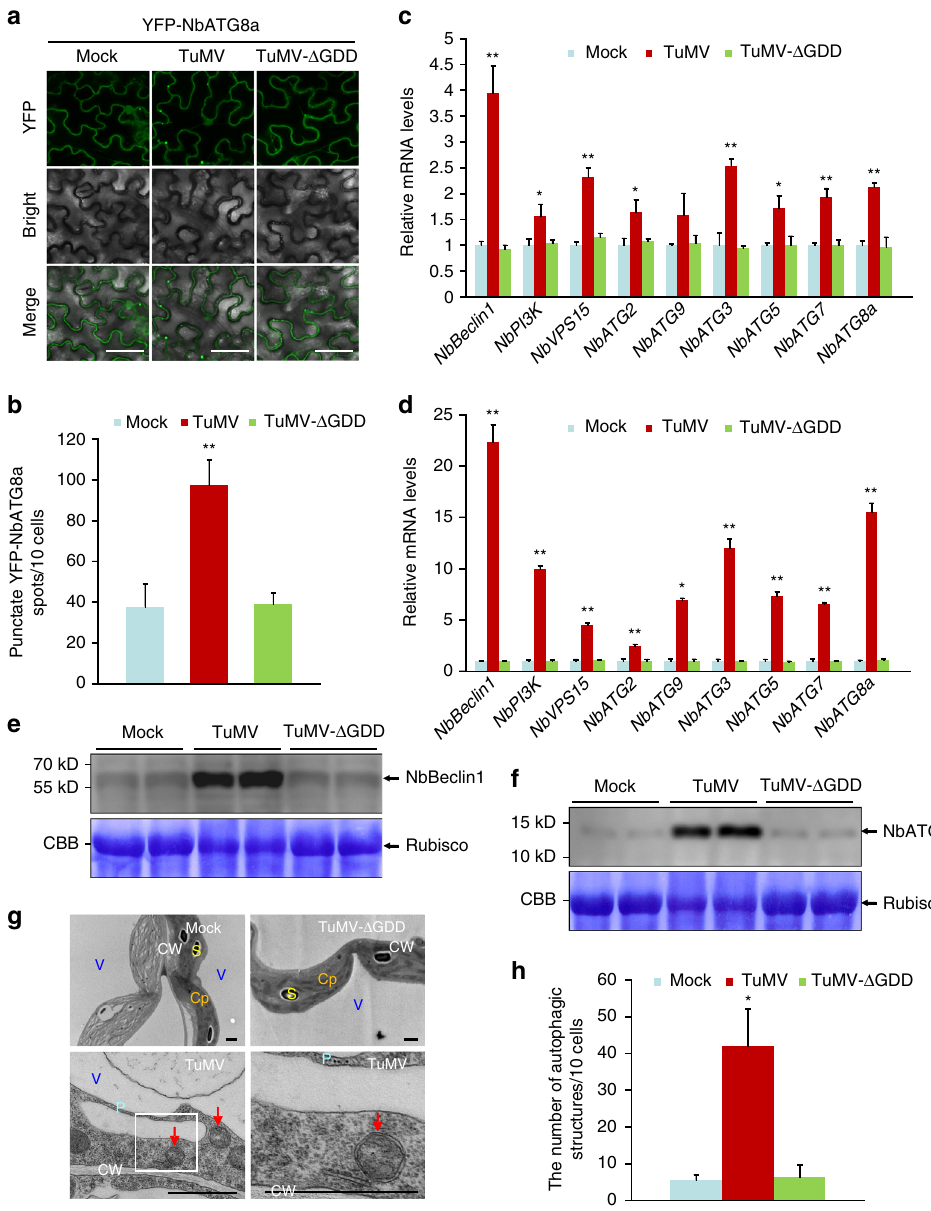
Fig. 1 TuMV infection activates autophagy. a Confocal micrographs showing N . benthamiana leaf cells co-in fi ltrated with Agrobacterium harboring a YFP-NbATG8a expression construct and Agrobacterium carrying an empty vector (mock) or a TuMV infectious clone (TuMV) or a TuMV replication- defective mutant (TuMV- Δ GDD) at 60 h post in fi ltration (hpi). Bars, 50 μ m. b The average number of YFP-NbATG8a spots per 10 cells. In fi ltration experiments were repeated three times and 60 cells in total were counted for the punctate spots. The average number was calculated using 10 cells as a unit. Values represent the mean spots ±standard deviation (SD) per 10 cells. c , d Effects of viral infection on the expression of autophagy components at 3 and 7 days post in fi ltration (dpi). N . benthamiana leaves were agroin fi ltrated with mock, TuMV, or TuMV- Δ GDD. Total RNAs were extracted from in fi ltrated zones at 3 dpi ( c ) or from newly emerged leaves at 7 dpi ( d ). Values represent the mean relative to the mock-treated plants ( n = 3 biological replicates) and were normalized with NbActin as an internal reference. e , f Immunoblotting analysis of total protein isolated from upper non-inoculated leaves of plants agroin fi ltrated with mock, TuMV, and TuMV- Δ GDD at 7 dpi with anti-Beclin1 ( e ) or anti-ATG8 ( f ) antibody. Coomassie Brilliant Blue R-250 (CBB)-stained Rubisco large subunit serves as a loading control. g Representative TEM images from upper non-inoculated leaves of N . benthamiana plants infected with mock, TuMV, and TuMV- Δ GDD at 7 dpi. Obvious autophagic structures (red arrows) were observed in TuMV-infected samples and the corresponding region in the white box in the left panel is magni fi ed in the right panel. Cp chloroplast, CW cell wall, P particle, S starch, V vacuole. Bars = 1 μ m. h The number of typical double-membrane autophagosomes in different samples in g . Experiments were repeated twice and typical autophagic structures were counted in 30 cells in each treatment. Values represent the mean number of autophagosomes ±SD per 10 cells. b , c , d , h Data were analyzed using Student ’ s t -test and asterisks denote signi fi cant differences between mock (or TuMV- Δ GDD) and TuMV-infected leaves (two-sided, * P < 0.05, ** P <